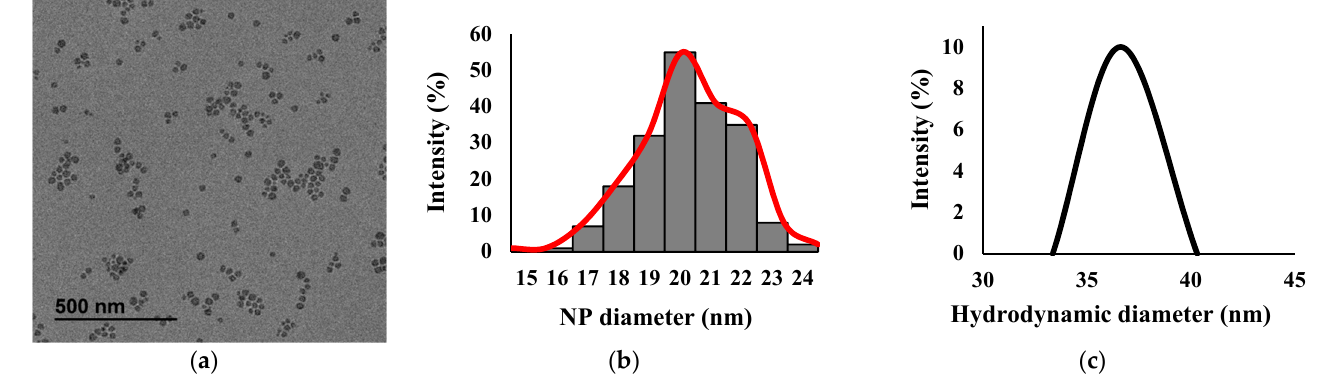
Figure 1. Characterization of functionalized SiO 2 NP using TEM and DLS. ( a ) A representative TEM image, ( b ) size distribution calculated from TEM images of SiO 2 NP, and ( c ) the DLS spectrum.